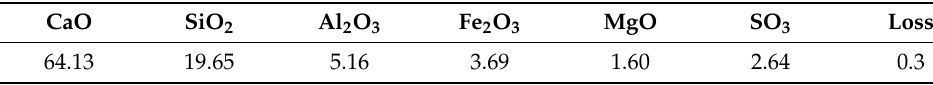
Table 1. Chemical composition of cement.